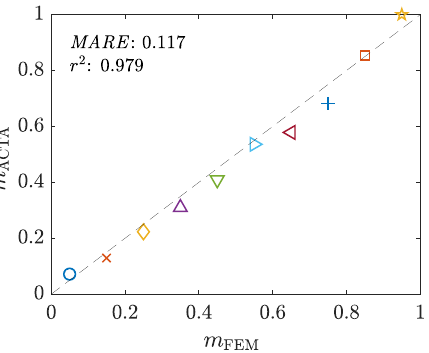
Figure 14. The correlation between the assigned ( m FEM ) and estimated ( m ACTA ) friction factors. The symbols point to different samples to be read using the legend of Figure